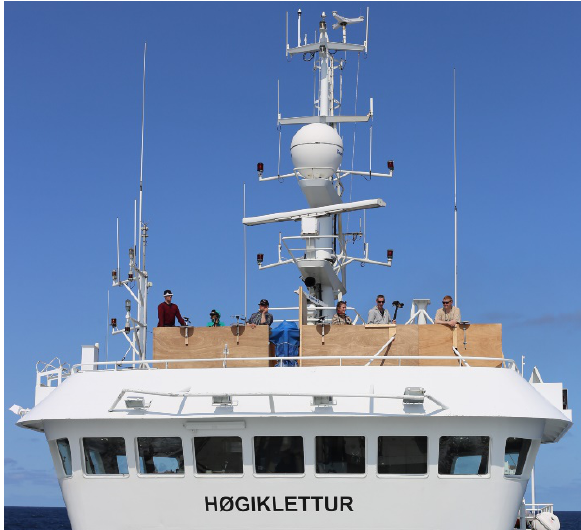
Figure 2. Survey vessel showing side-by side independent observing platforms used during the NASS 2015 Faroese survey. Photo credit: Natural History Museum, Faroe Islands.